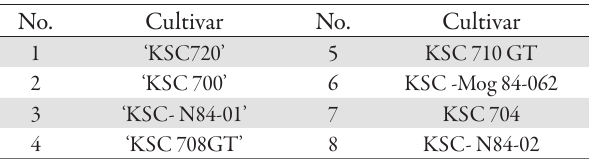
Tab. 1. Cultivars of canola used for drought tolerance assessment